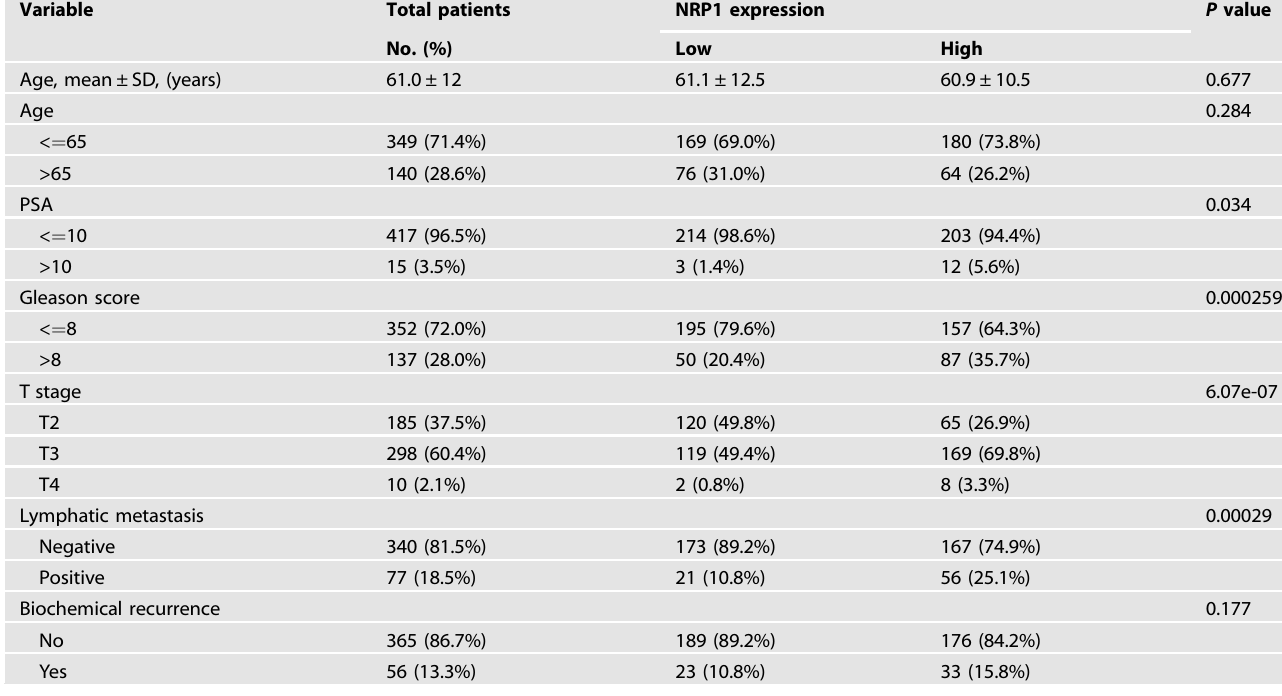
Table 1. Association between the expression of NRP1 and clinicopathological characteristics.